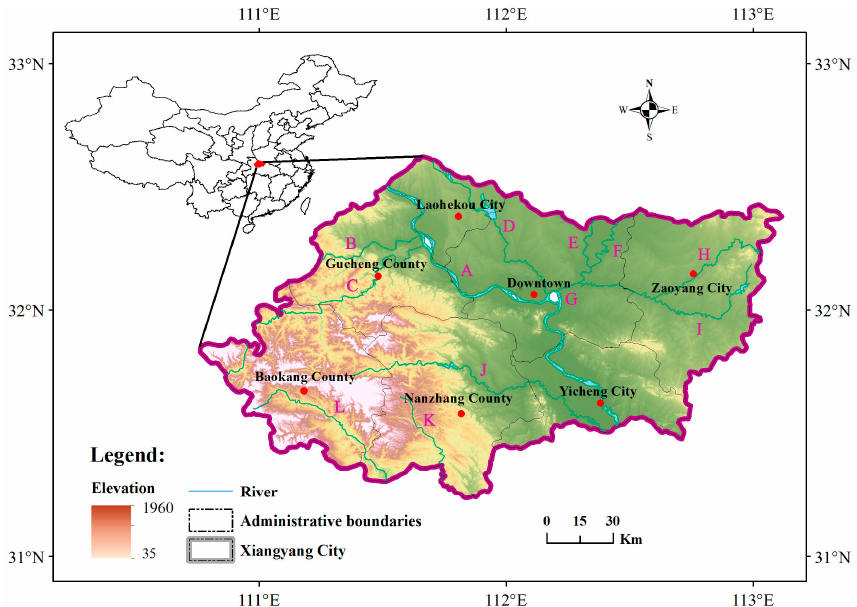
Figure 1. Location of the Study Area, Rivers and Administrative Divisions. A : Han River; B : North River; C : South River; D : Xiaoqing River; E : White River; F : Tang River; G : Tangbai River; H : Sha River; I : Gun River; J : Man River; K : Zhang River; L : Ju River.